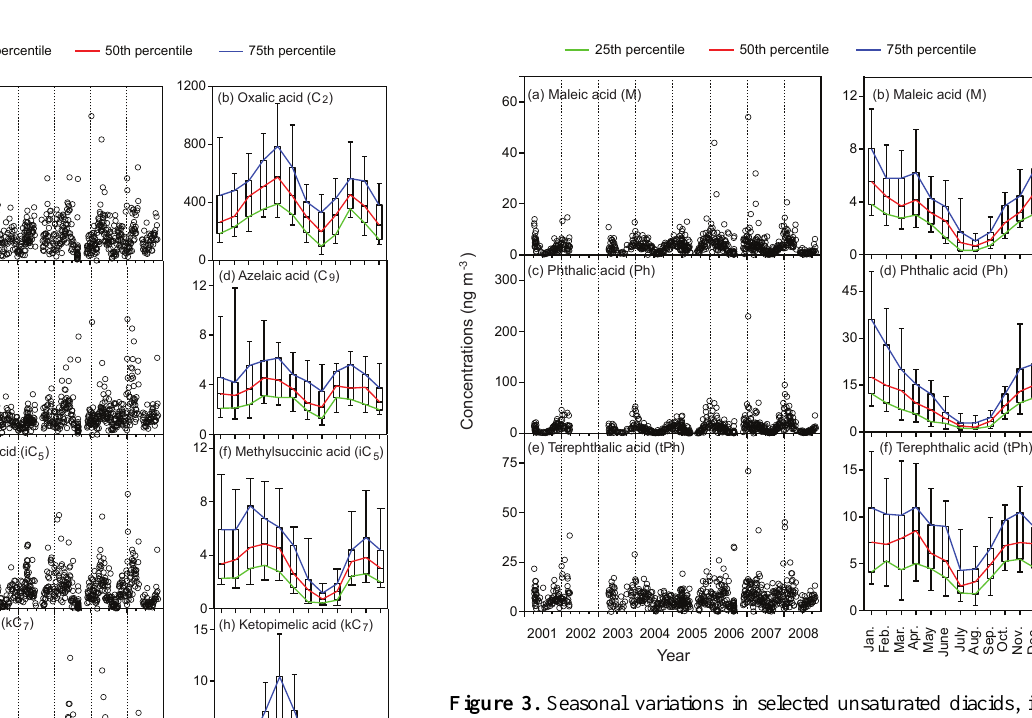
Figure 3. Seasonal variations in selected unsaturated diacids, in- cluding maleic (a, b) , phthalic (c, d) and terephthalic (e, f) acids, in ambient aerosol samples. The right panels are drawn based on the monthly binned concentrations irrespective of the years. The lower and upper whiskers represent the 10th and 90th percentiles, respec- tively. The outliers are excluded in the right panels to avoid any distortion in the